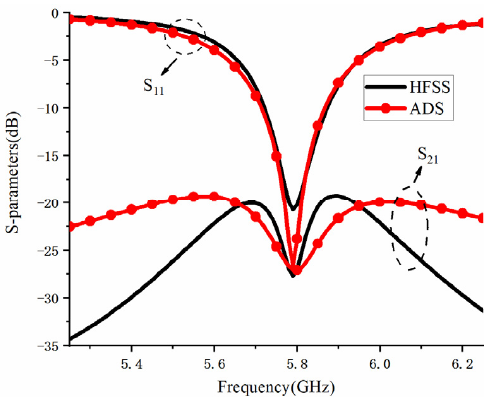
Figure 13. Comparison between the HFSS and ADS results.